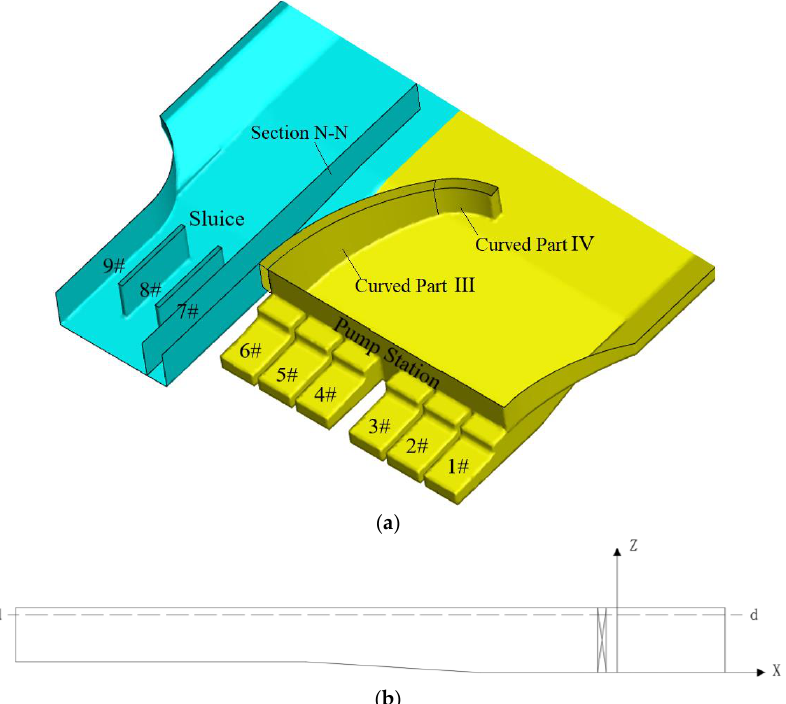
Figure 14. Diagrammatic sketch of the position of characteristic section under the free-draining condition: ( a ) diagrammatic sketch of the position of characteristic section N-N; ( b ) sectional profile N-N.